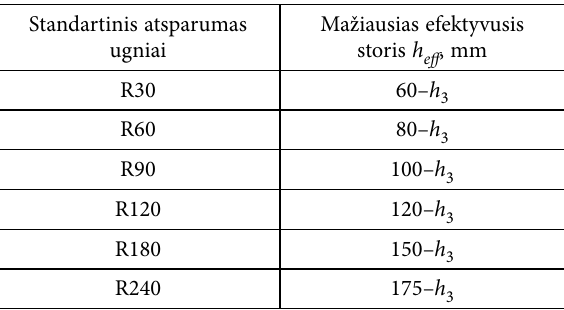
Table 6. Minimal effective thickness as standard resistance function to fire Standartinis